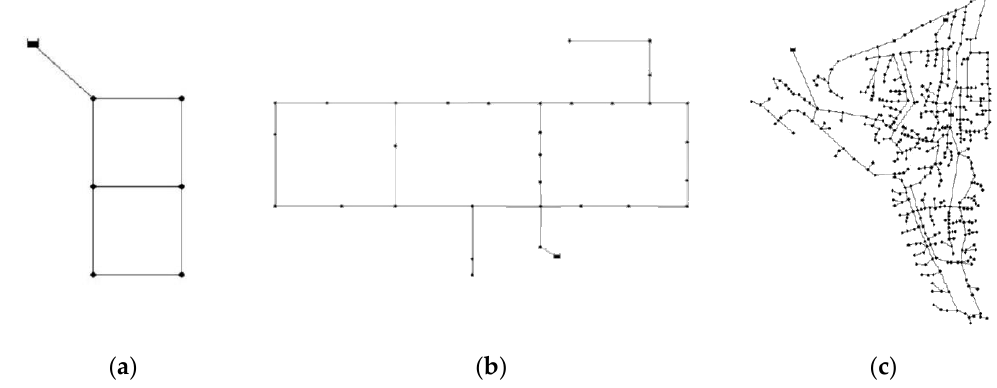
Figure 2. Benchmark networks: ( a ) two loop, ( b ) Hanoi, ( c ) Balerma. Table 2. Networks characteristics.